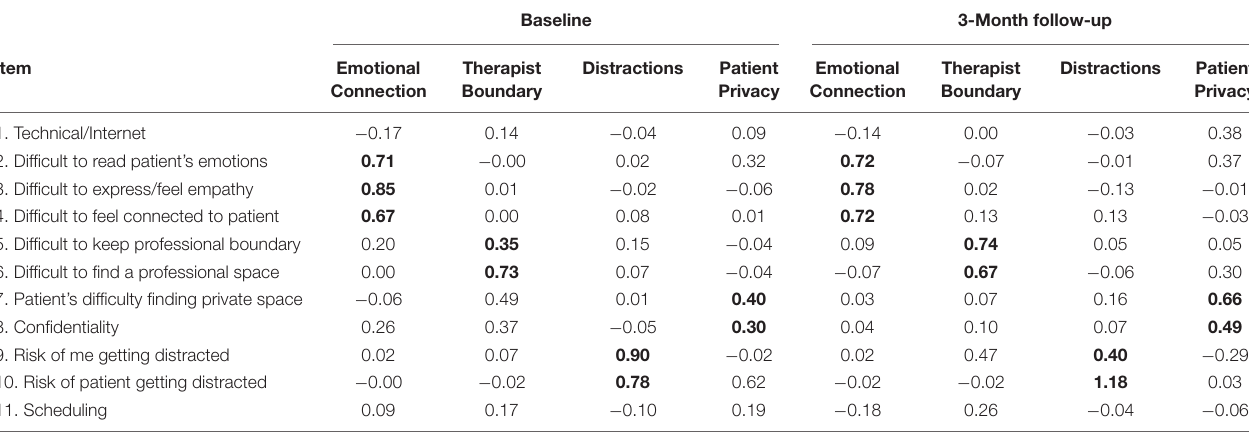
TABLE 3 | Pattern loadings for the four-factor dimensional model at baseline ( N = 1,257) and 3-month follow-up ( N = 320).